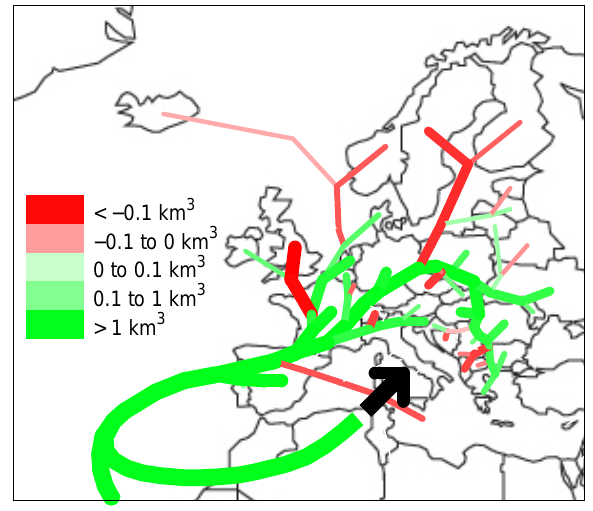
Fig. 3. Net virtual water fluxes (import minus export) from Euro- pean countries to Italy in